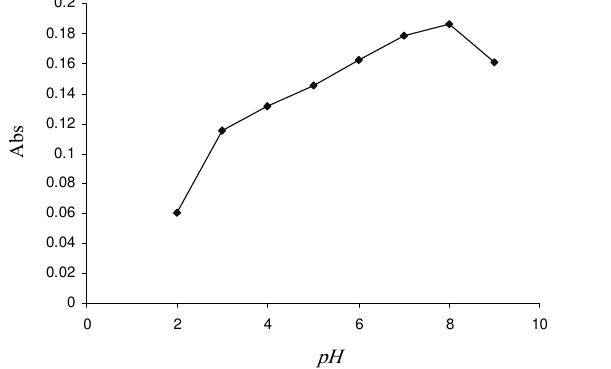
pH Figure 2 . Effect of pH on the absorbances of silver ion